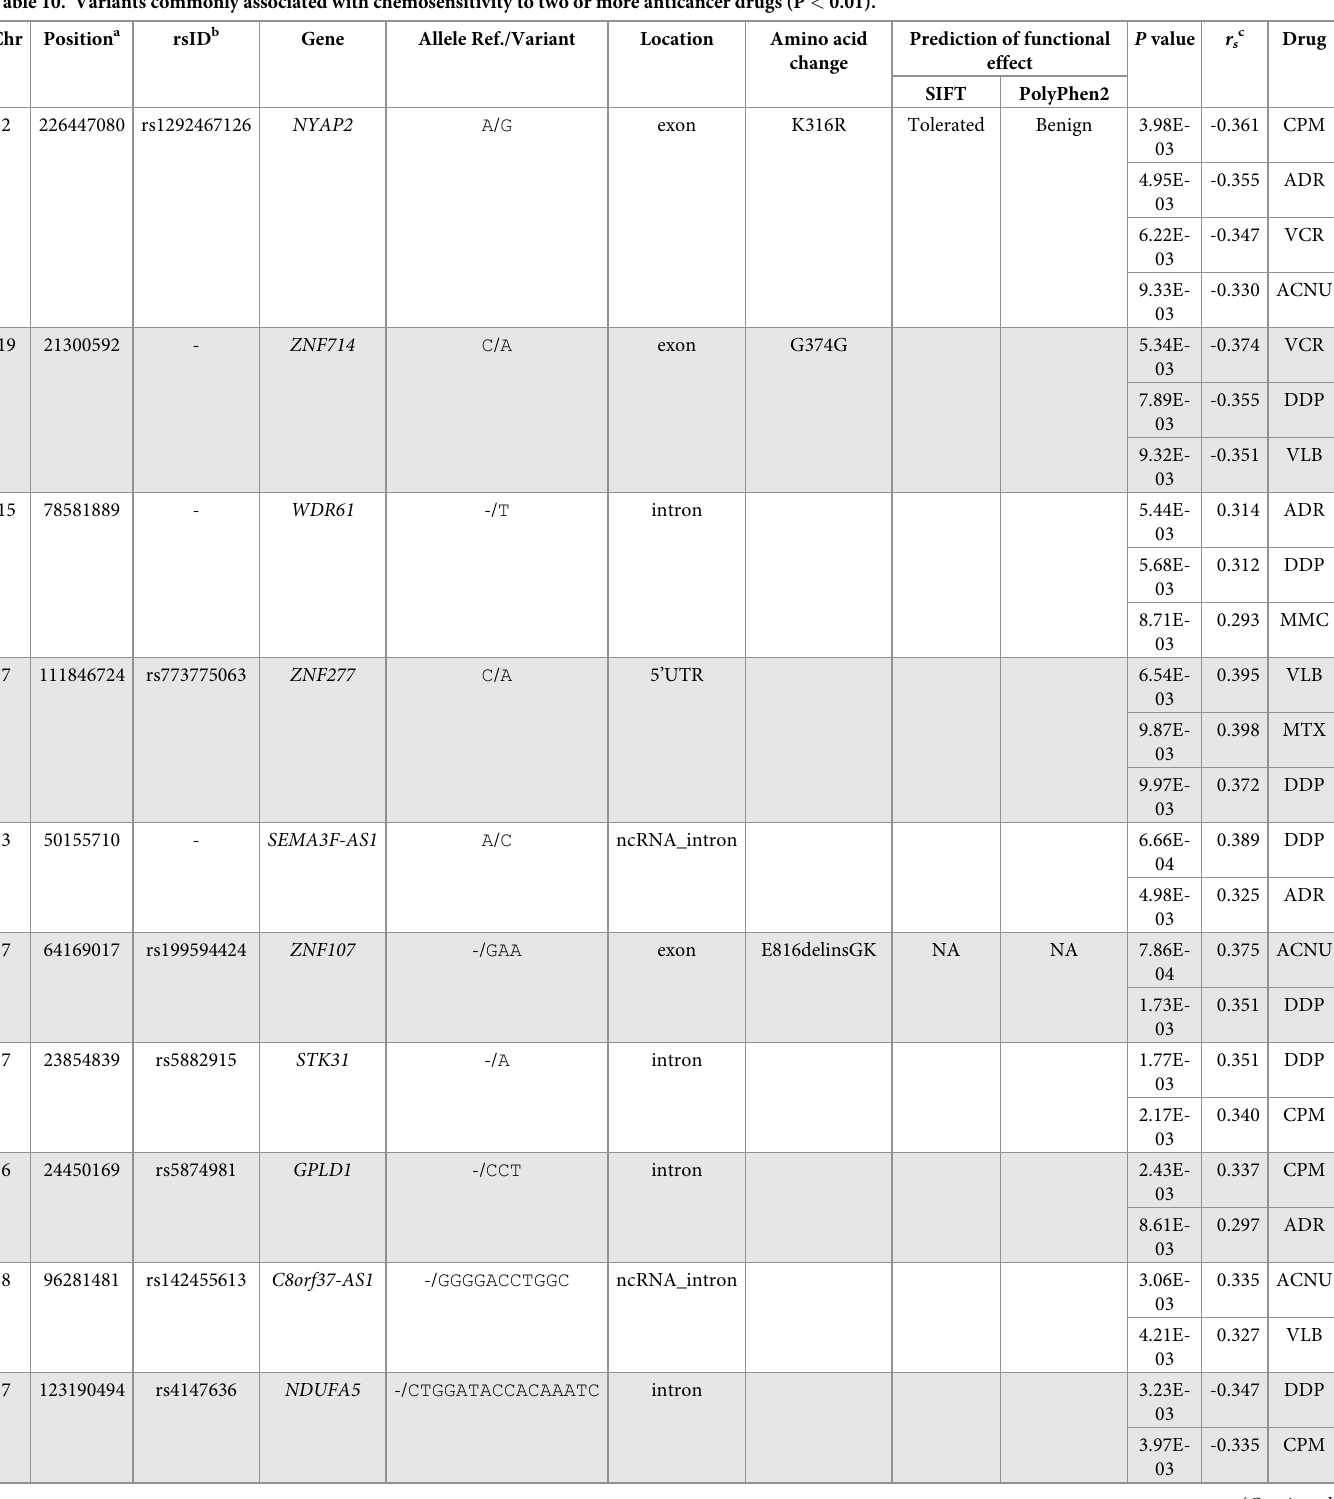
Table 10. Variants commonly associated with chemosensitivity to two or more anticancer drugs (P <